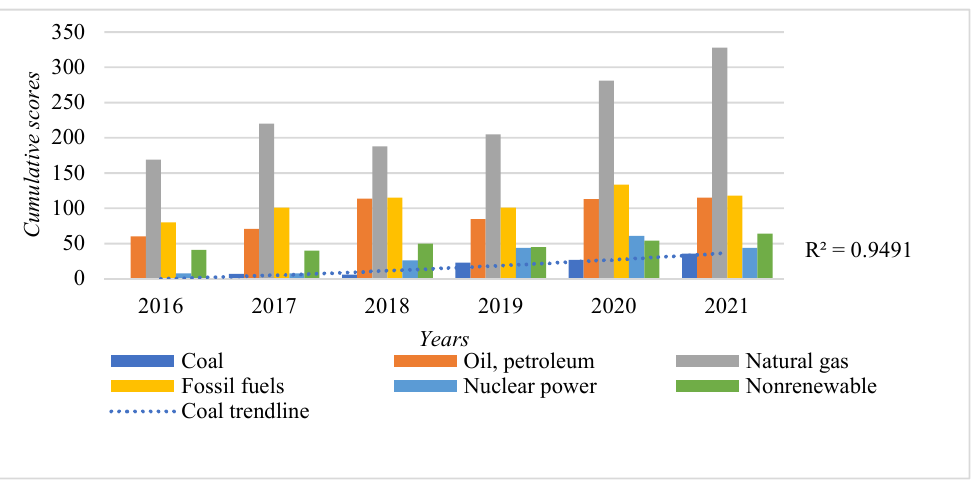
Figure 5. Citations on nonrenewable energy sources in the context of energy security education with